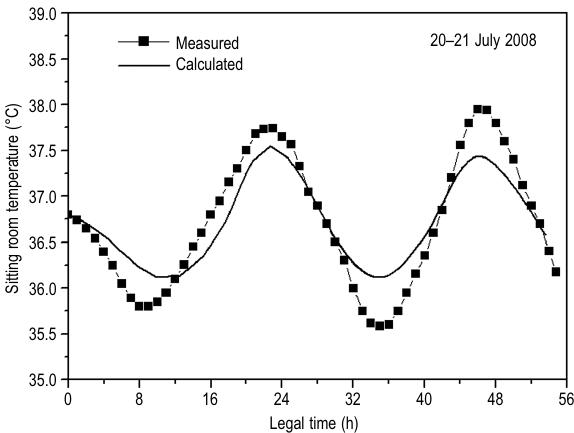
(b)Fig. 5. Measured and simulated temperature of sitting